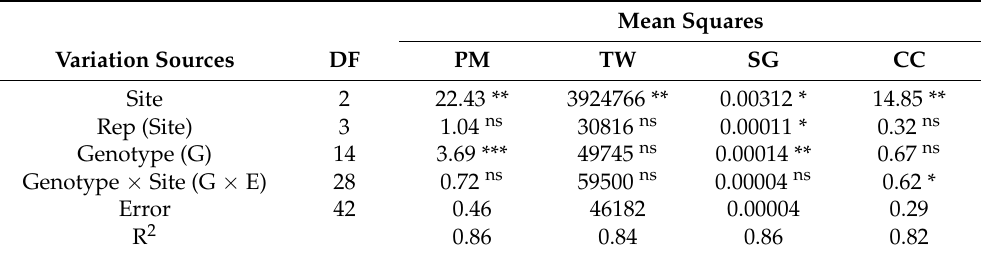
Table 6. Mean squares and significant tests for agronomic and quality traits among 6 parents and 15 F 1 progenies evaluated in three